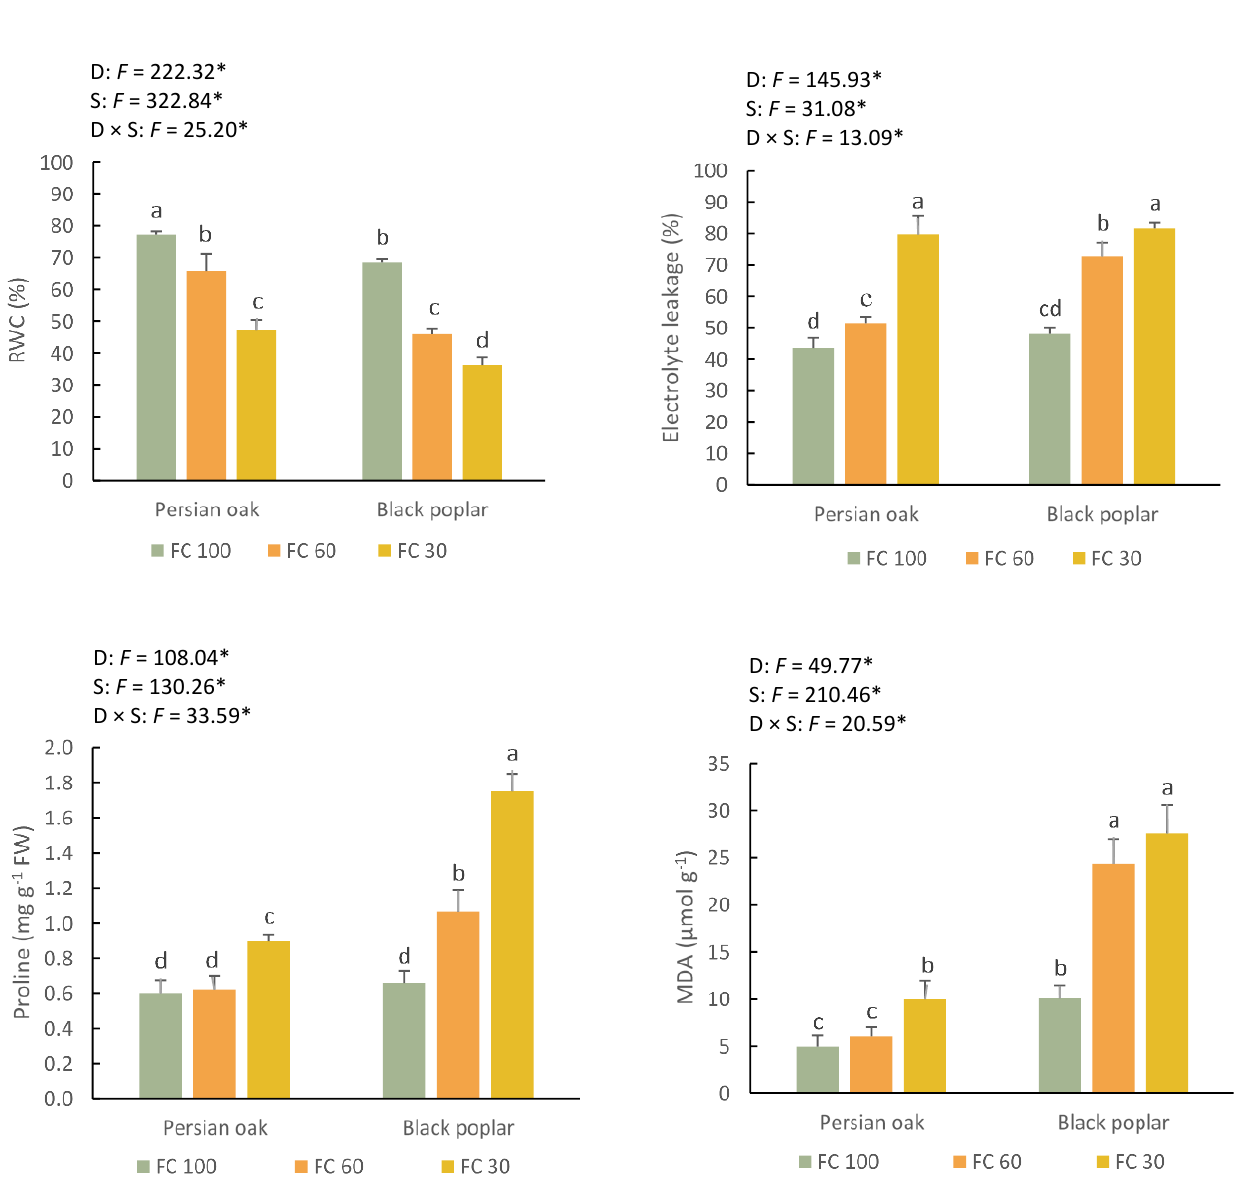
Figure 5. Relative water content (RWC), electrolyte leakage (EL), proline, and malondialdehyde (MDA) content of leaves of Persian oak and black poplar seedlings subjected to three different soil water regimes. Means ± standard deviation, n = 3 blocks. Different lower-case letters indicate statistically significant differences based on Duncan’s multiple range post-hoc test ( α = 0.05). In the presence of a significant interaction between drought (D) and species (S), the significance letters are valid across species but only remain valid within species when the interaction (D × S) was not significant. FW = fresh weight. * p < 0.05